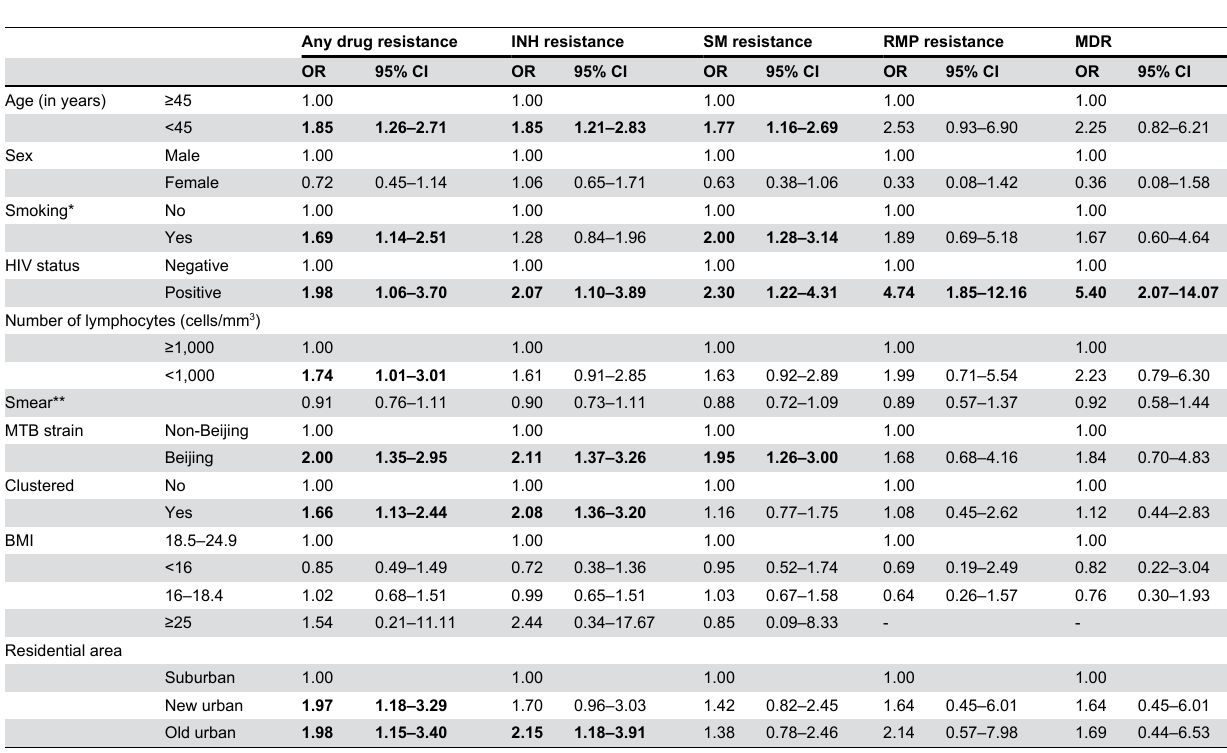
Table 4. Univariate analysis using the logistic regression model of the associations between potential risk factors and drug resistance ( n =